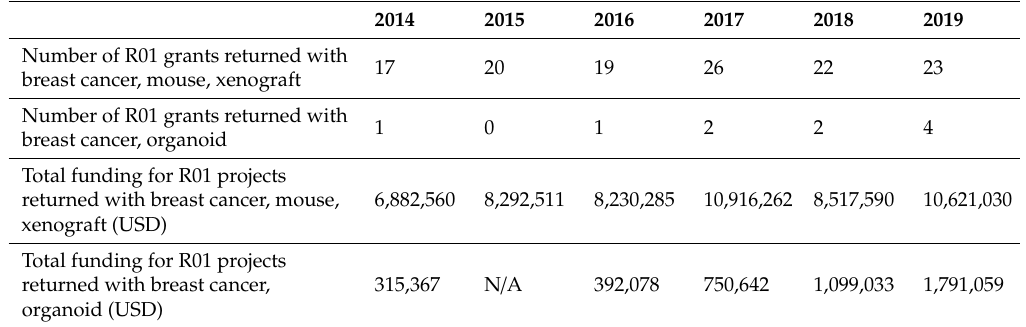
Table 3. NIH research project funding, categorized as R01 and year 1 of support, retrieved from NIH RePORT (Table 1) using either breast cancer AND mouse AND xenograft or breast cancer AND organoid between 2014 and 2019. Grants were further scrutinized to ensure that breast cancer was the focus of the research, and that either xenografts or organoids were one of the methodologies described. Total funding for grants that fulfilled these criteria was